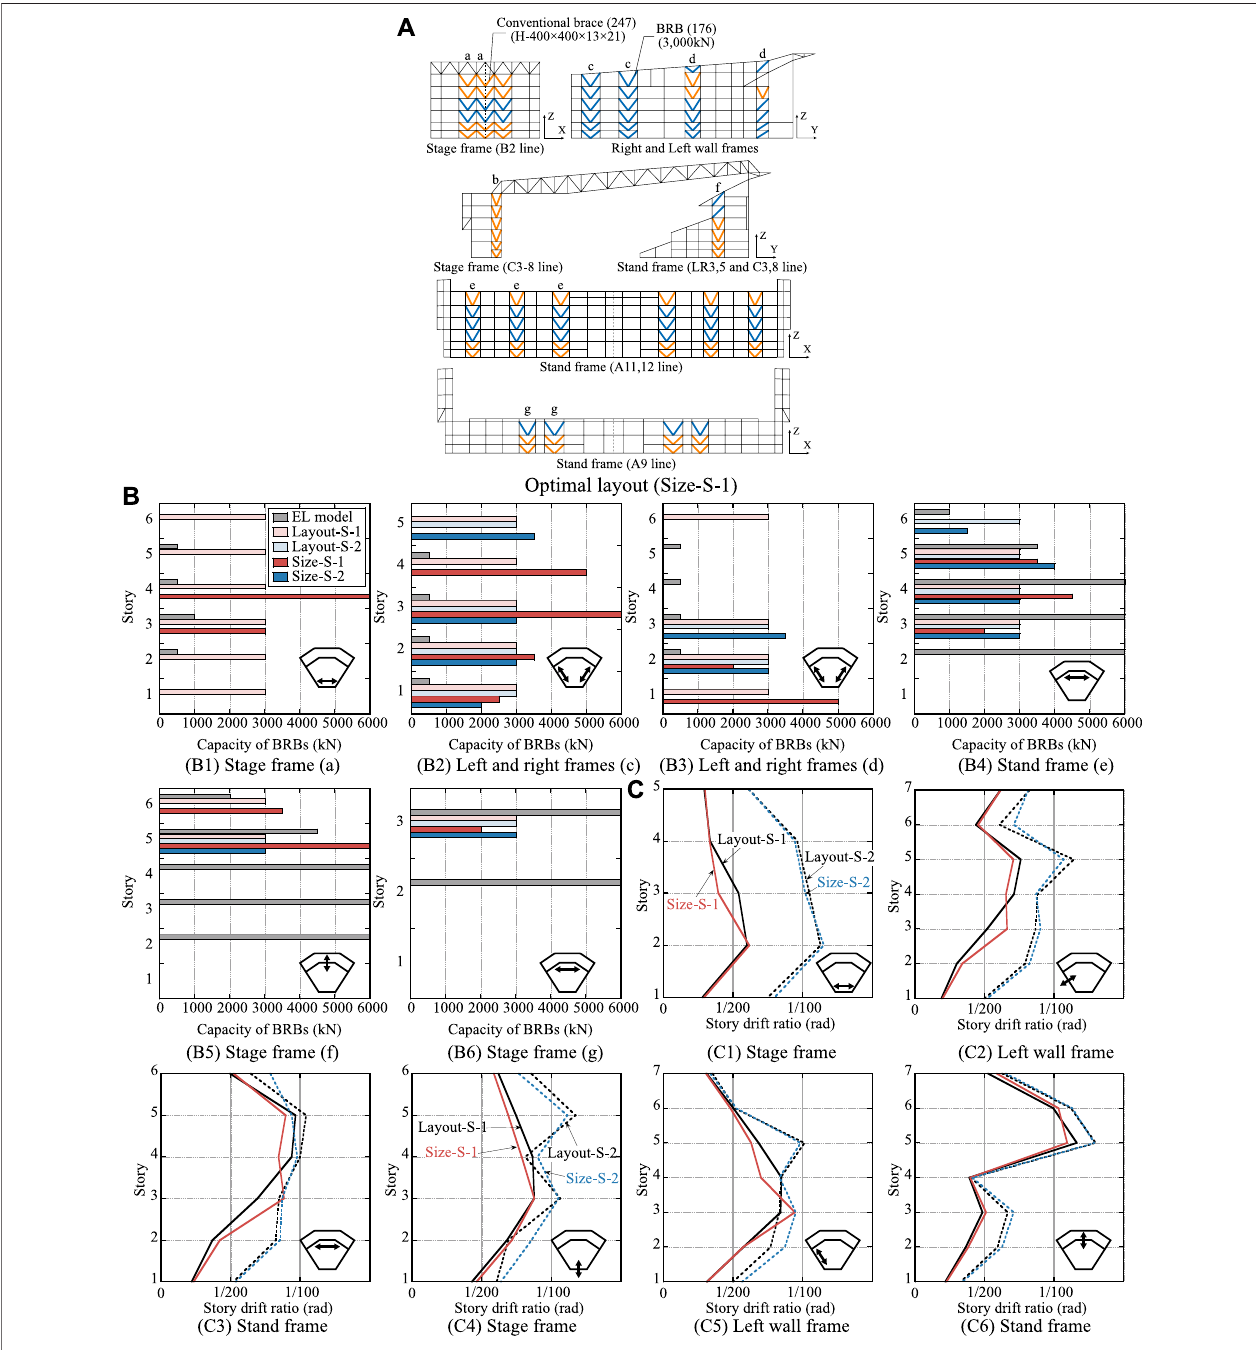
FIGURE 11 | Optimal solution (Size-S-1 and Size-S-2): (A) Optimal placement (Size-S-1), (B) Capacity distribution of BRBs, (C) Maximum story drift ratio.